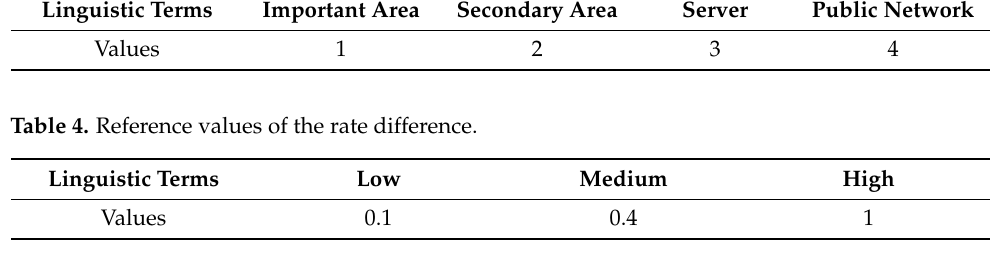
Table 5. Reference values of the time interval difference.